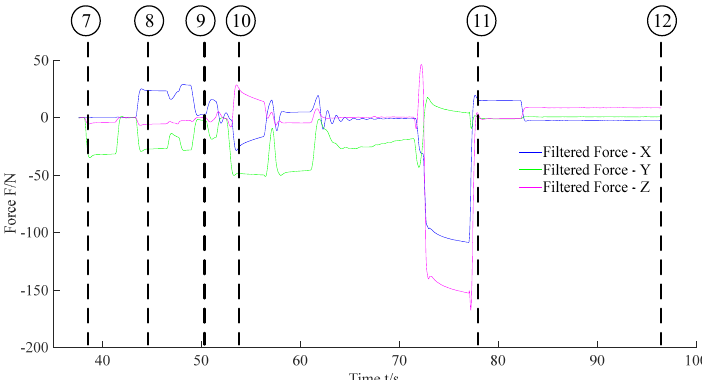
Figure 17. Feedback force during the F / T location and the insertion assembly processes.